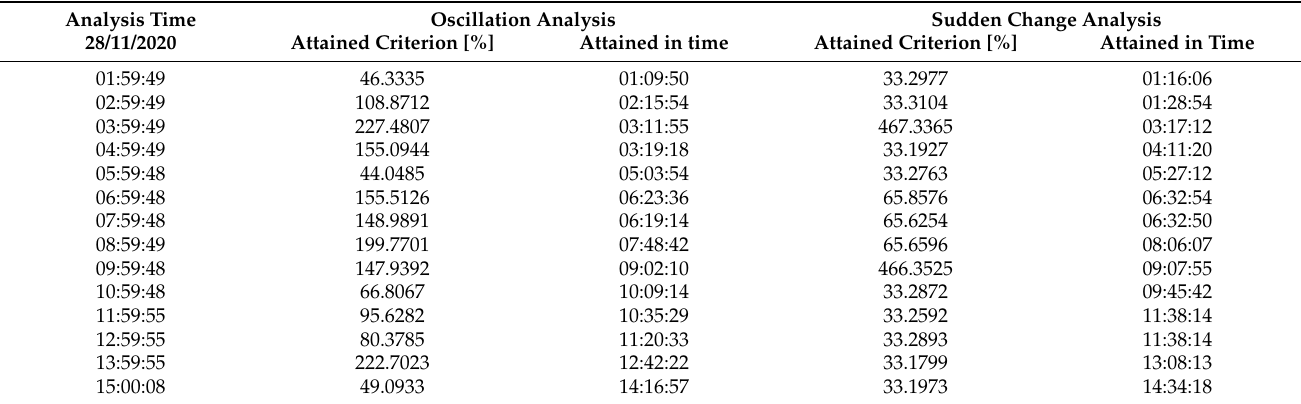
Table 3. Numerical results of cfn:: T1.1_out0